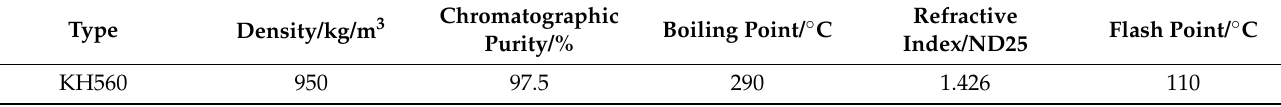
Table 4. Physical properties of KH-560 coupling agent.